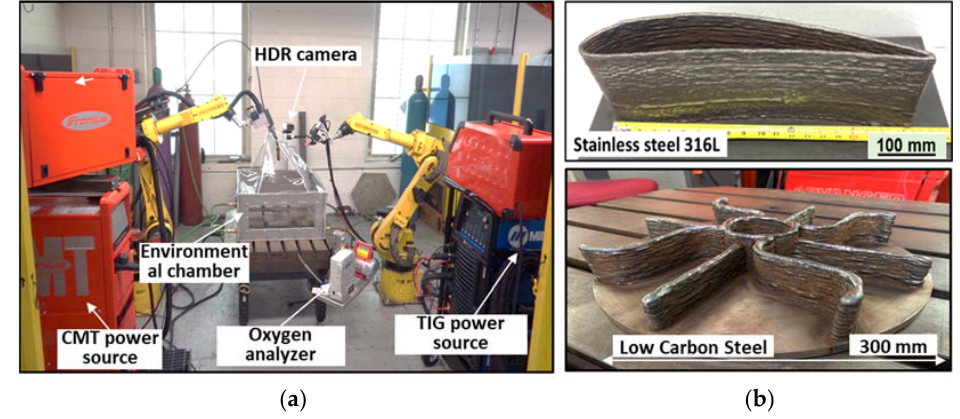
Figure 1. ( a ) Multihead WAAM system and ( b ) wire + arc additively manufactured structures.